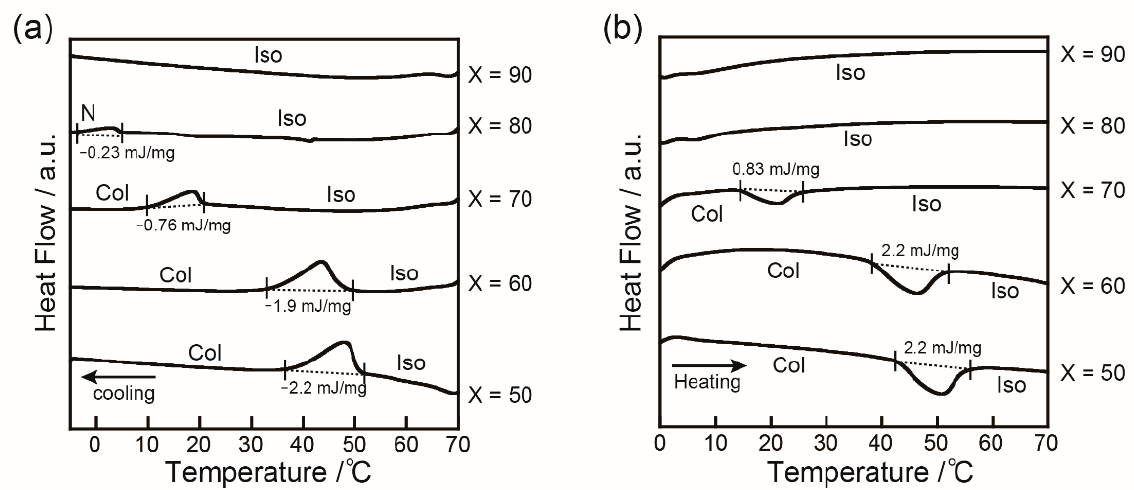
Figure 7. DSC thermograms of the pQpdS-Ch /H 2 O mixtures: ( a ) on cooling and ( b ) on heating.